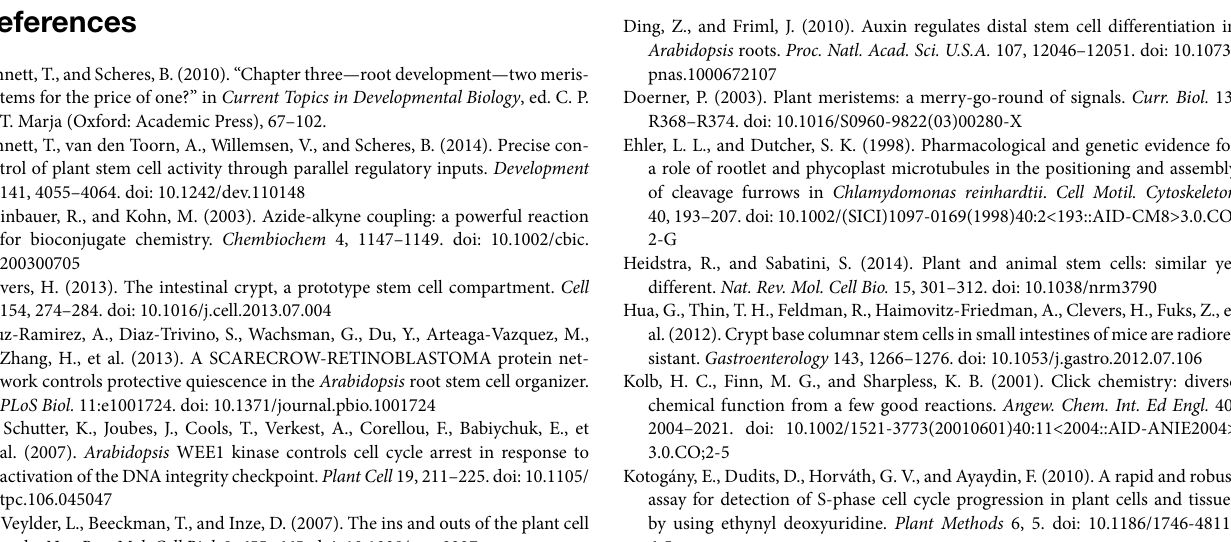
FIGURE 4 | Comparison of EdU and F-ara-EdU staining patterns in the columella root cap. (A) WT treated with 10 m M EdU for 24 h ( n = 18). (B) WT treated with 10 m M F-ara-EdU ( n = 12) for 24 h. (C) Quantification of the percentage of roots with EdU or F-ara-EdU stain in the indicated columella root cap layer. **** represents position of the QC. CSC: layer of